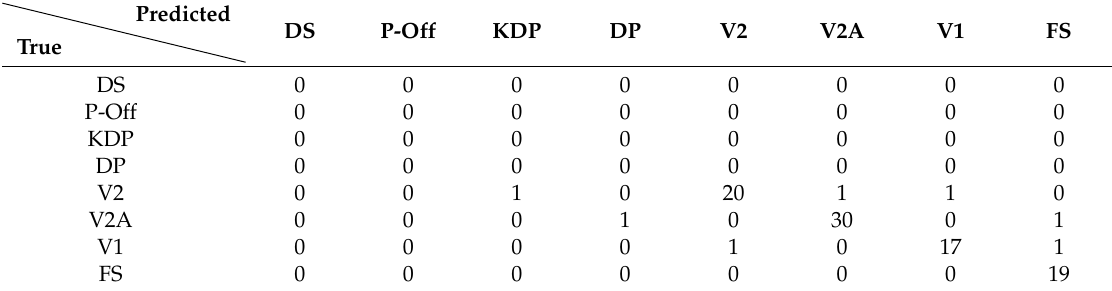
Table 14. Confusion matrix for the flat course, skating style validation set of skier 3 when using the sports biomechanics configuration of